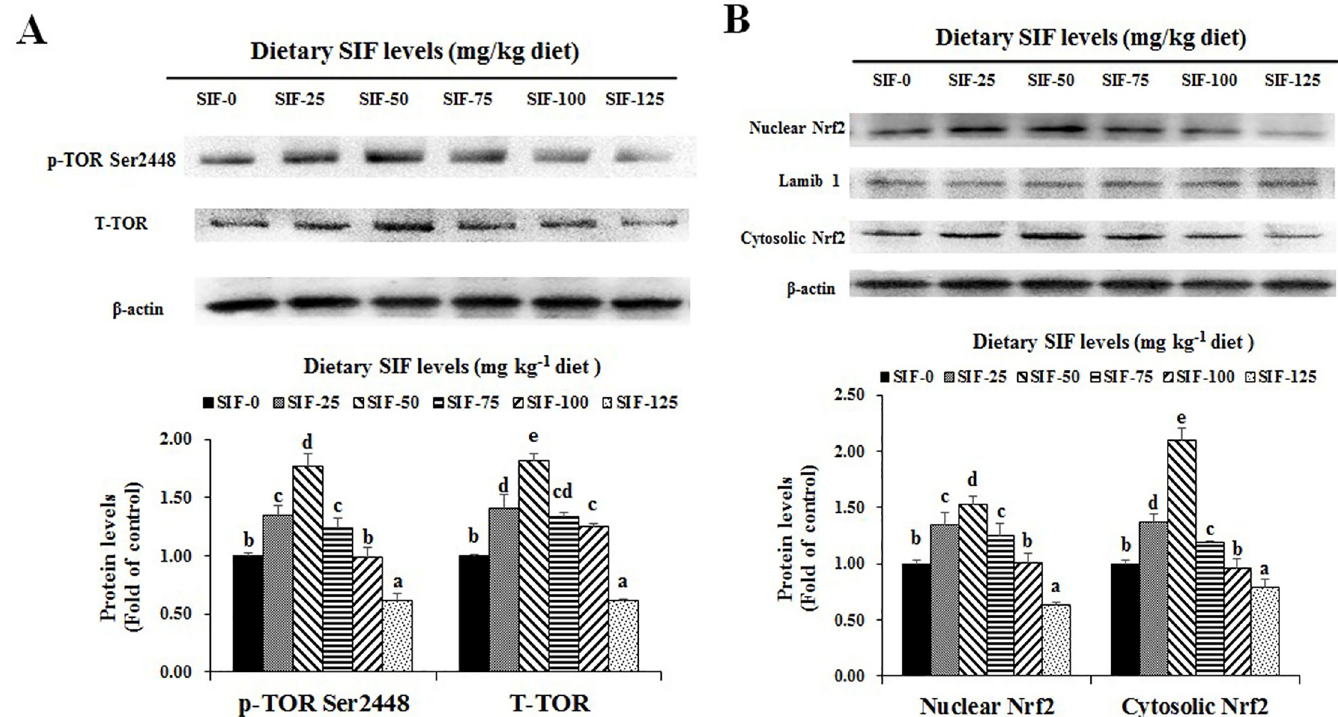
Fig 4. Effects of SIF on the protein levels of TOR and Nrf2 in the muscle of grass carp. (A) p-TOR Ser2448 and T-TOR protein levels; (B) Nuclear Nrf2 and cytosolic Nrf2 protein levels. Values are means (n = 6), error bars indicate SD, and different letters above a bar denote the significant difference between treatments ( P < 0.05). p-TOR Ser2448, Phosphorylation on residue Ser2448 of TOR, T-TOR, total-TOR protein levels; Nuclear Nrf2, Nuclear Nrf2 protein levels; cytosolic Nrf2, cytosolic Nrf2 protein levels.